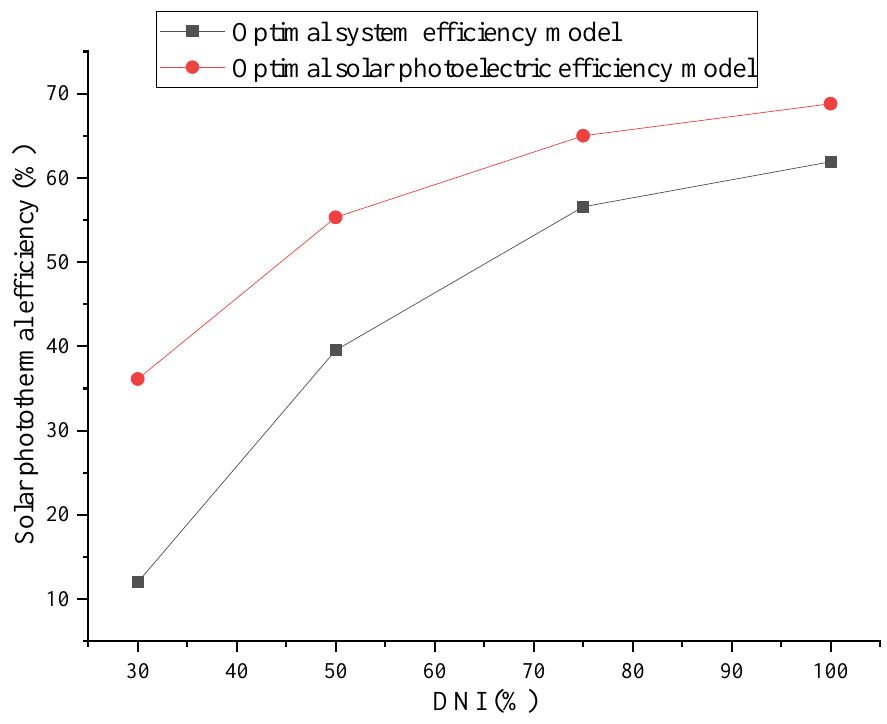
Figure 6. Trend of solar photothermal efficiency with DNI reduction for the optimal model of system/solar photoelectric efficiency under design load.